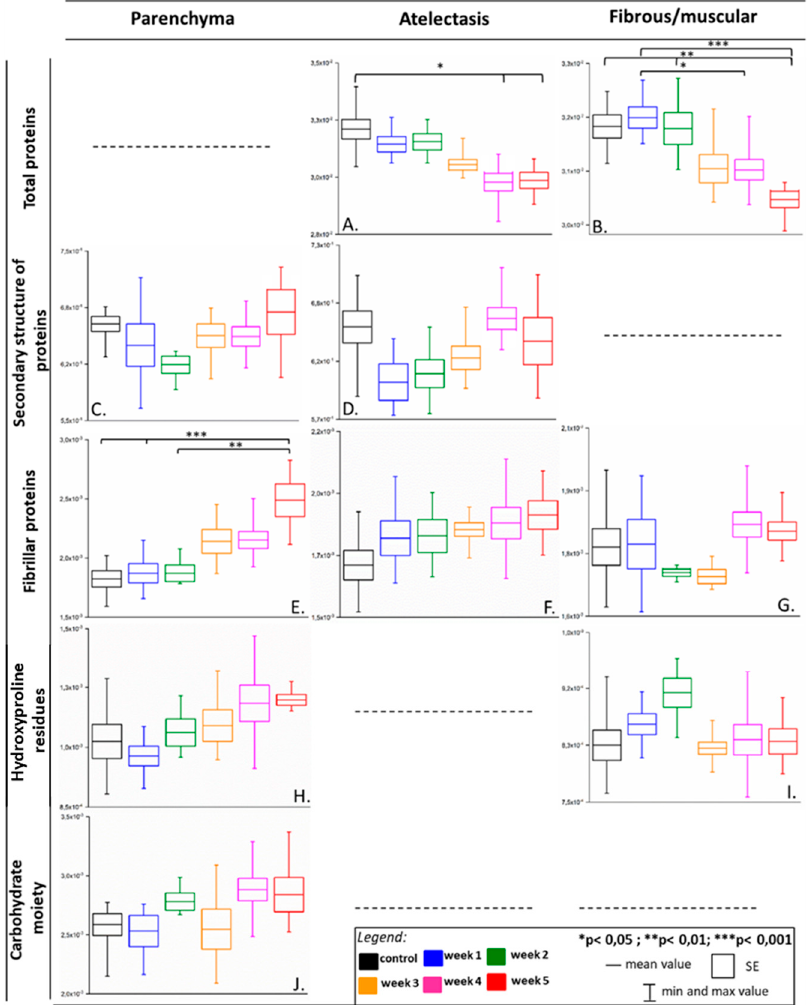
Figure 3. Box diagrams of integral intensities for the selected bands showing biochemical changes in parenchyma, atelectasis, and fibrous/muscular tissue in the metastasis progression in the lungs. Integration regions: total proteins [(1707–1608 cm − 1 ) + (1589–1485 cm − 1 )], secondary structure of proteins [(1589–1485 cm − 1 )/(1707–1608 cm − 1 )], fibrillar proteins (1286–1193 cm − 1 ), hydroxyproline